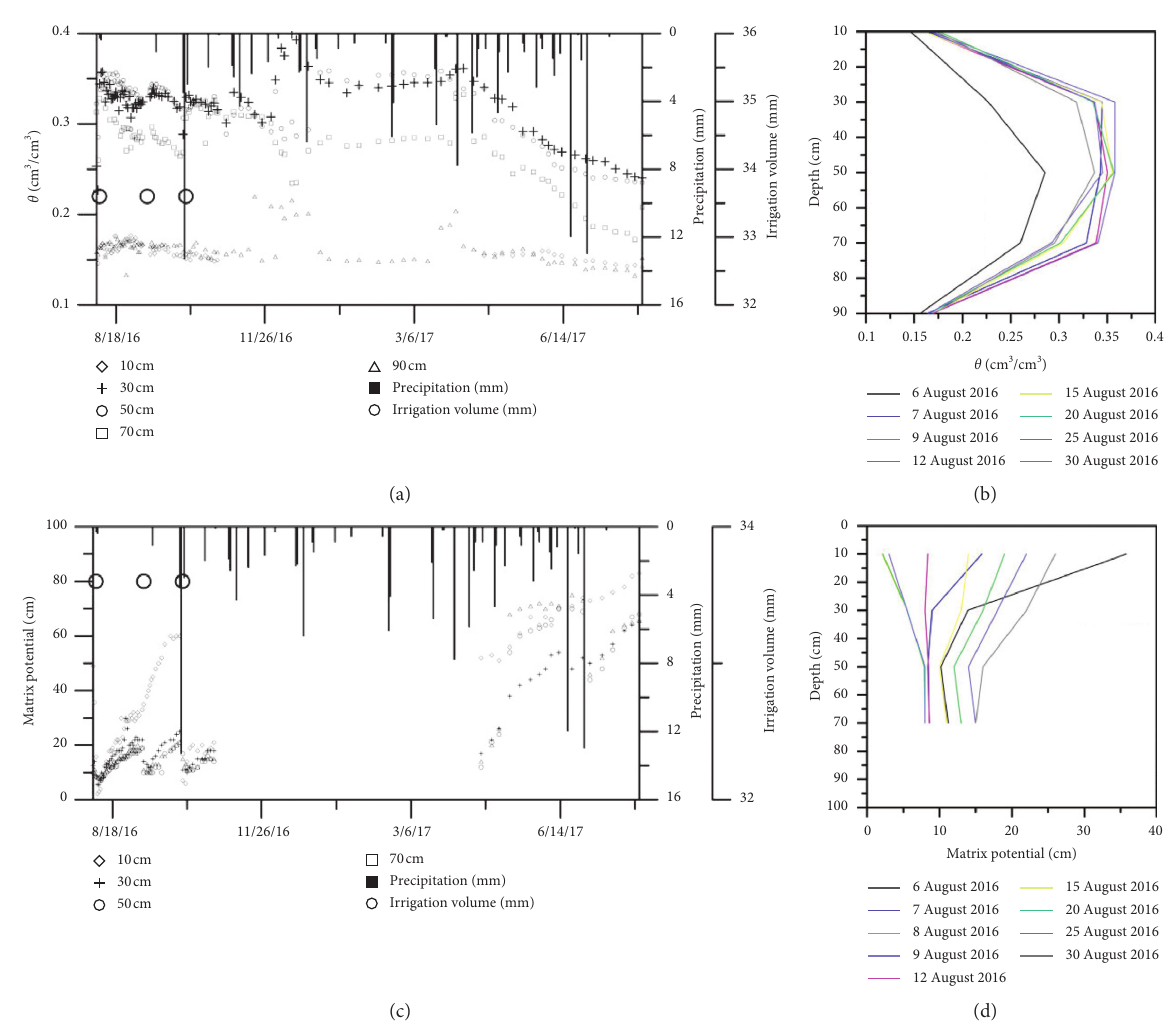
Figure 7: Water distribution in soil with a thickness of 70cm with uncompaction: (a) water distribution at different depths; (b) response of water content to irrigation; (c) matrix potential at different depths; (d) response of matrix potential to